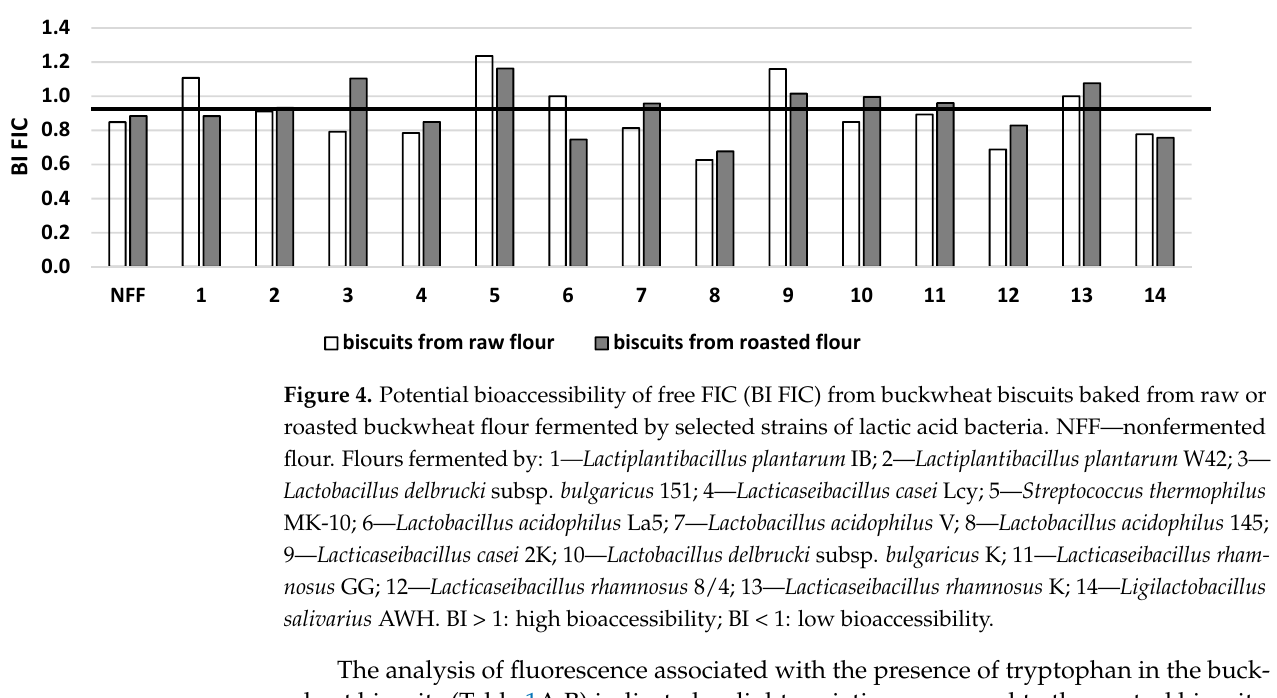
Figure 4. Potential bioaccessibility of free FIC (BI FIC) from buckwheat biscuits baked from raw or roasted buckwheat flour fermented by selected strains of lactic acid bacteria. NFF—nonfermented flour. Flours fermented by: 1 —Lactiplantibacillus plantarum IB; 2— Lactiplantibacillus plantarum W42;